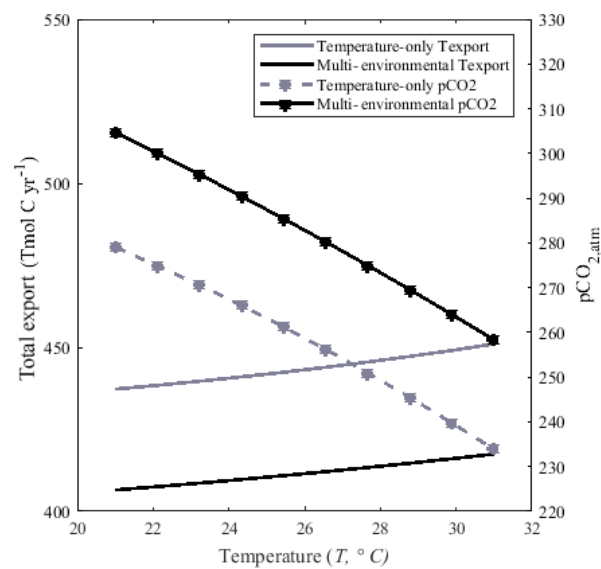
Figure 11. The effect of changing sea surface temperature ( ◦ C) on p CO 2 , atm and total carbon export ( T molCyr − 1 ) in the temperature-only and multi-environmental model. Phosphate con- centrations are 0.3µM in the tropical and 0.05µM in the subtropi- cal box. Multi-environmental model total carbon export is the solid grey line, and p CO 2 , atm is the dashed grey line. Temperature-only model total carbon export is the solid black line, and p CO 2 , atm is the dashed black